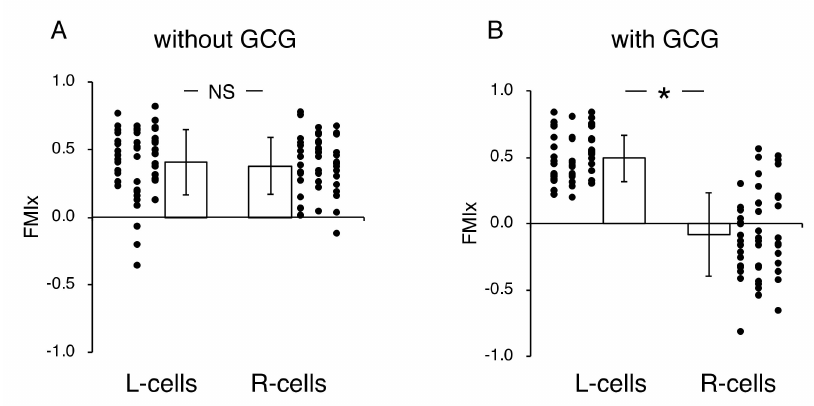
Figure 4. Forward migration index (FMI) parallel to the di ff usion path (FMI x ) without ( A ) and with the GCG in place ( B ). Without the GCG involved, the FMI x values for the L-cells and R-cells were not di ff erent (NS, p = 0.60). In contrast, with the GCG in place, the FMI x value for the R-cells was significantly smaller compared to that of the L-cells. Data were accumulated from five independent experiments in which 10 cells were sampled in each experiment. Error bars represent the SD. *, p < 0.05, as judged by Student’s t -test.